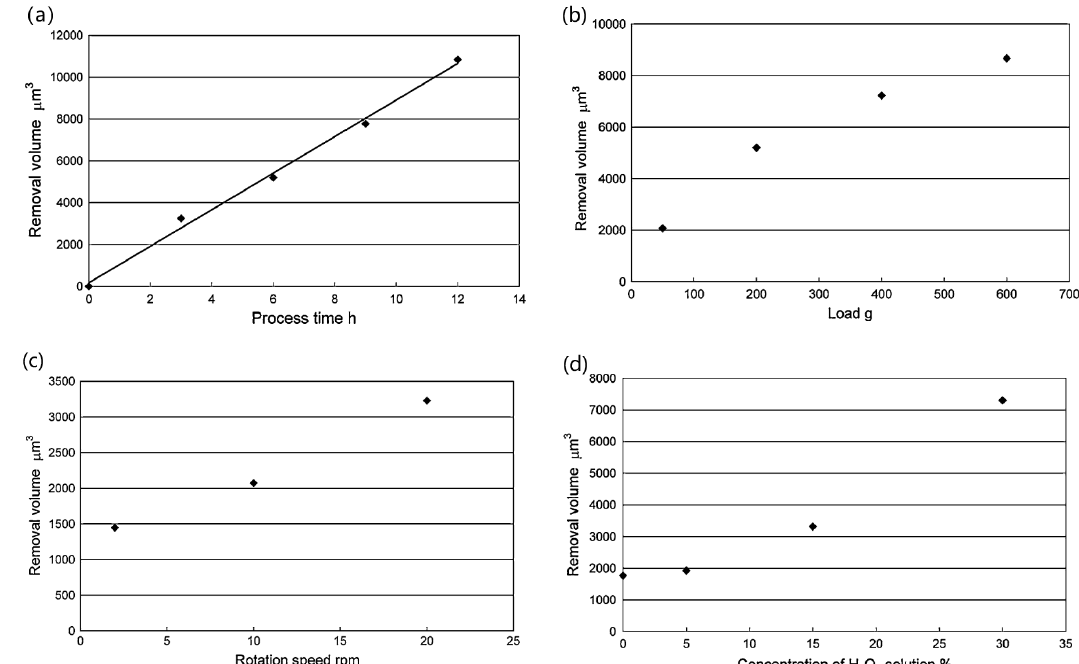
Figure 28. Relationship between removal volume and ( a ) process time, ( b ) contact load, ( c ) rotation speed, and ( d ) concentration of H 2 O 2 solution [62].